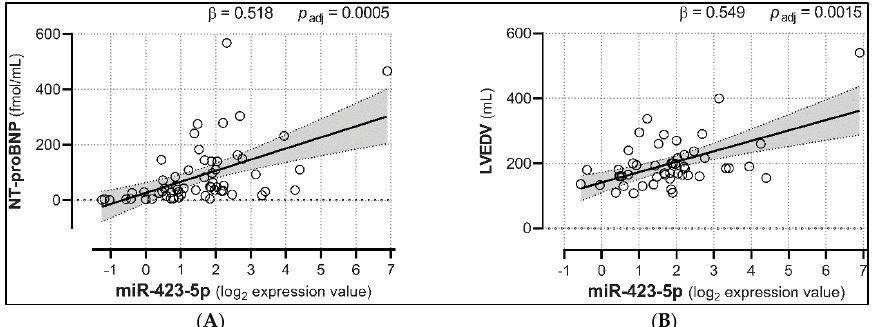
Figure 4. Expression levels of plasma miR-423-5p are associated with both NT-proBNP and LVEDV. Figure HF-regulated miR-423-5p showed positive associations with both NT-proBNP ( A ) and LVEDV ( B ).